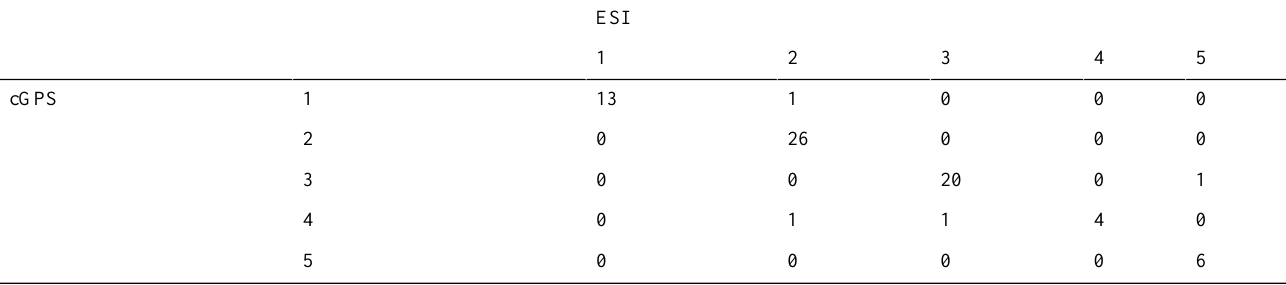
Table 5. A matrix representation of severity score distribution between the ESI and calculated triage score.